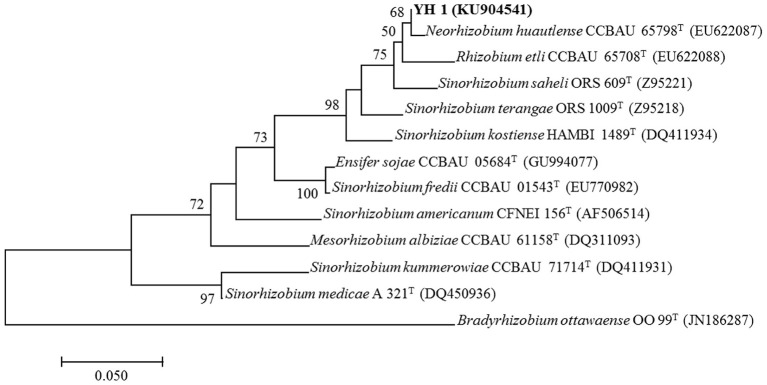
Maximum likelihood tree of nifH sequences (453 bp) for L. leucocephala-isolated strain YH1 constructed using the Kimura 2-parameter model with bootstrap confidence based on 1,000 repetitions. Accession numbers retrieved from GenBank are shown in parentheses. The scale bar denotes 5% nucleotide substitutions per site. Values lower than 50 are not shown at the nodes. Superscript “T” following each strain number indicates type strain.